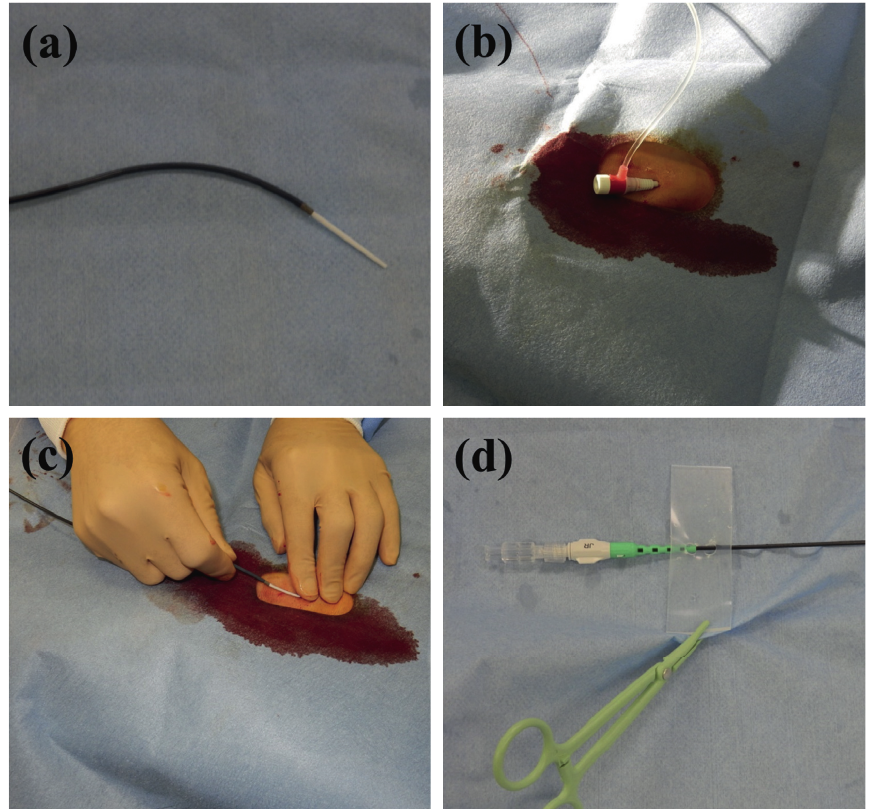
Figure 3: Sheathless transradial percutaneous coronary intervention procedure. (a) A central dilator is introduced into a guiding catheter. (b) A 4-Fr conventional sheath is inserted into the radial artery. (c) Following introduction, the sheath is exchanged for a sheathless guiding catheter connected to a supplied central dilator over a 0.035-inch wire. (d) A silicon-based stopper is linked to the proximal shaft of the sheathless guiding catheter and anchored to a surgical drape using forceps to avoid slippage.